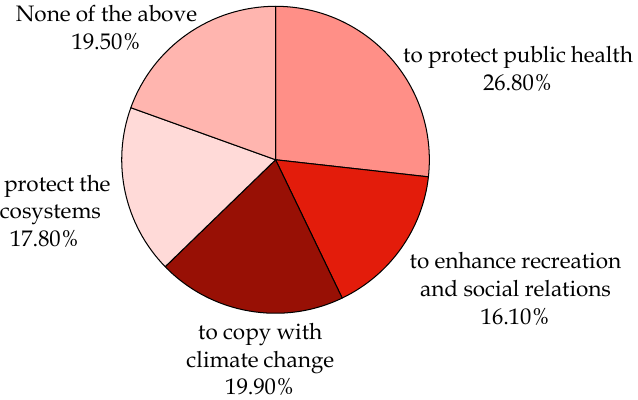
Figure 6. Responses on services accepted for an increase in the municipal tax for improving UGAs.